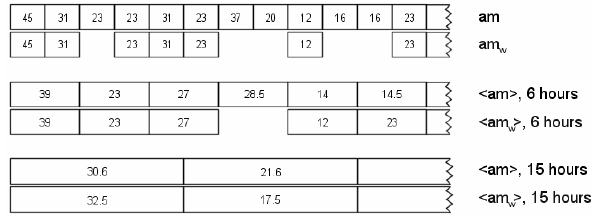
Figure 4. Fig. 4. Illustration of the construction of averages from identical non-overlapping periods of am and am w of increasing duration. Il- lustrative values of am and am w are given and the consequent aver- ages of am and am w for 6- and 15-h averaging